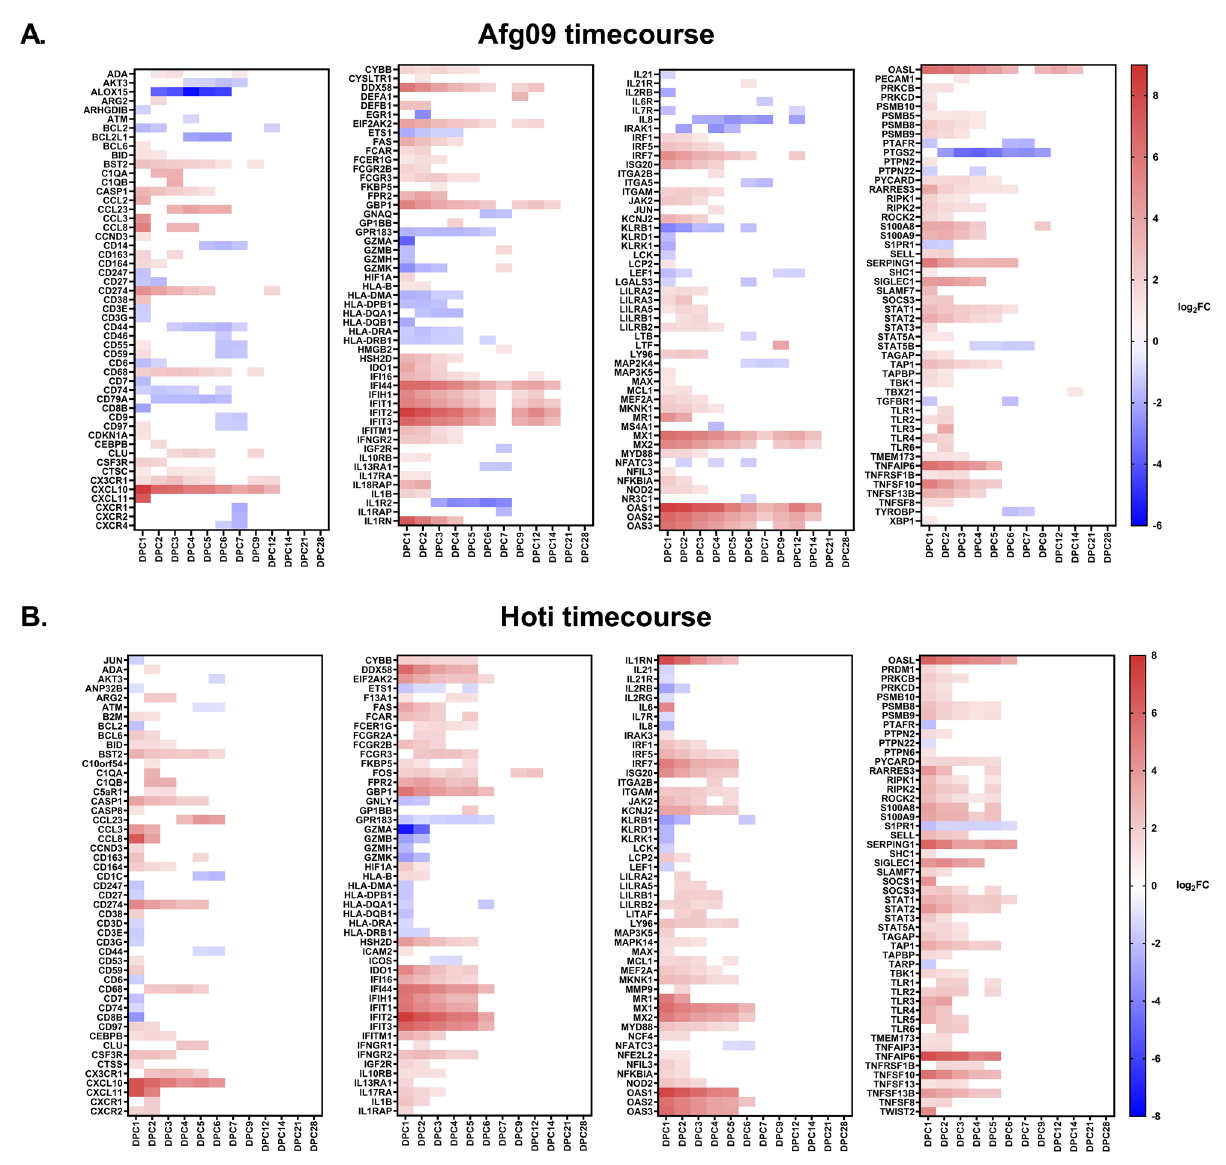
Figure 2. Gene expression changes in NHPs during CCHFV (Afg09 and Hoti) disease. ( A ) Heat map showing expression levels of genes relative to pre-infection levels for Afg09. Only significant genes are shown. ( B ) Heat map showing expression levels of genes relative to pre-infection levels for Hoti. Only significant genes are